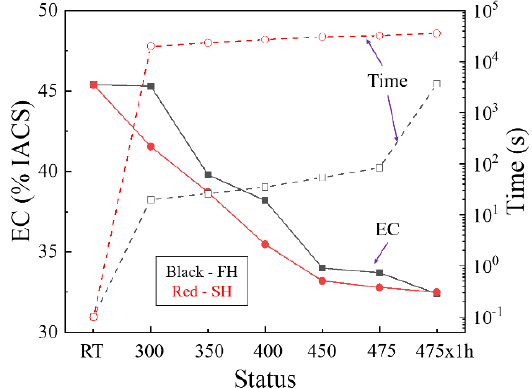
Figure 6. The EC evolution and the heating time corresponding to the temperature during the heat- up and solution treatment. and solution